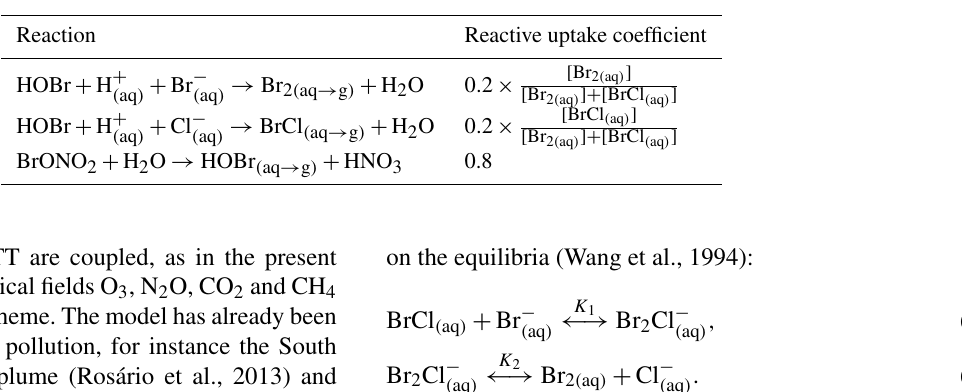
Table 1. Heterogeneous reactions in the model and their associated reactive uptake coefficients on sulfate aerosol. See Sect. 2.3.1 for de- scription of the calculation of the ratio [BrCl ( aq ) ] / [Br 2 ( aq )